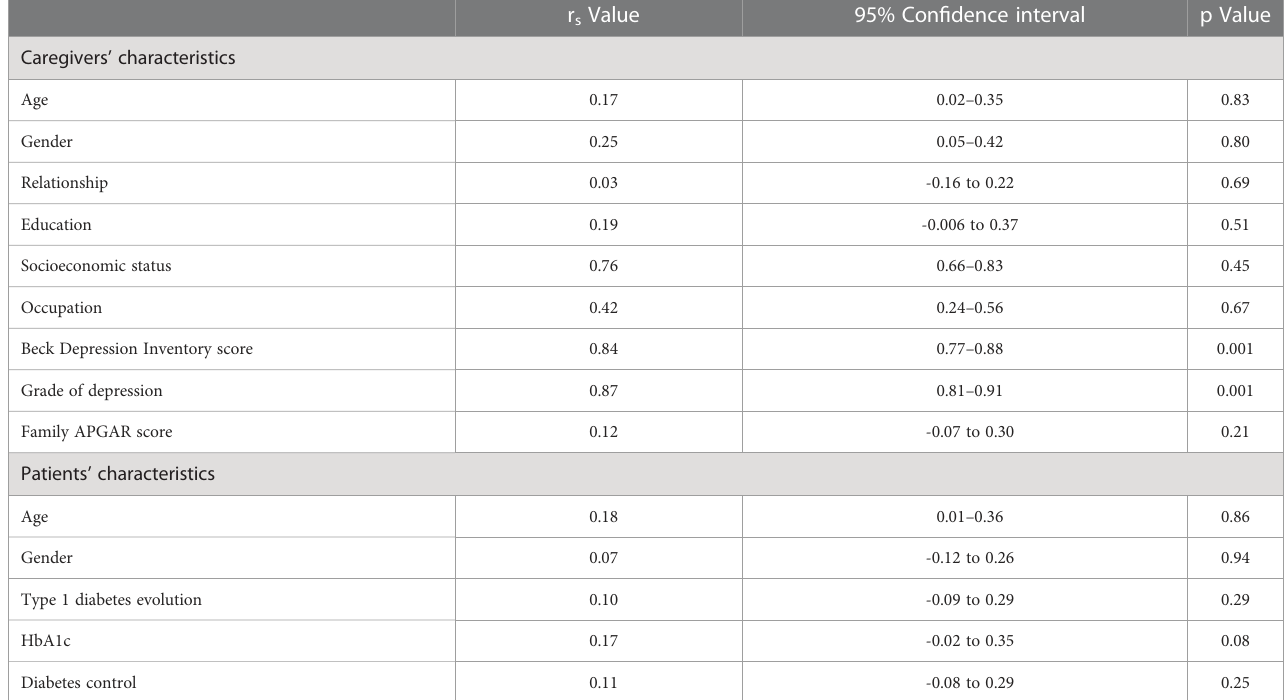
TABLE 4 Associations between caregiver burden and sociodemographic variables of caregivers, the Beck Depression Inventory score, the family APGAR score, and clinical characteristics of patients.